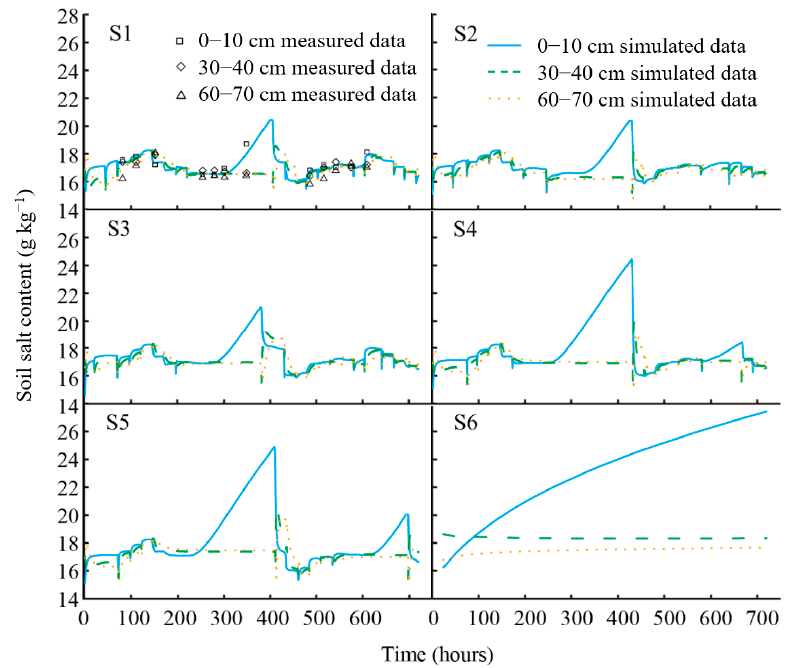
Figure 9. The variation of soil salt content in each scenario.